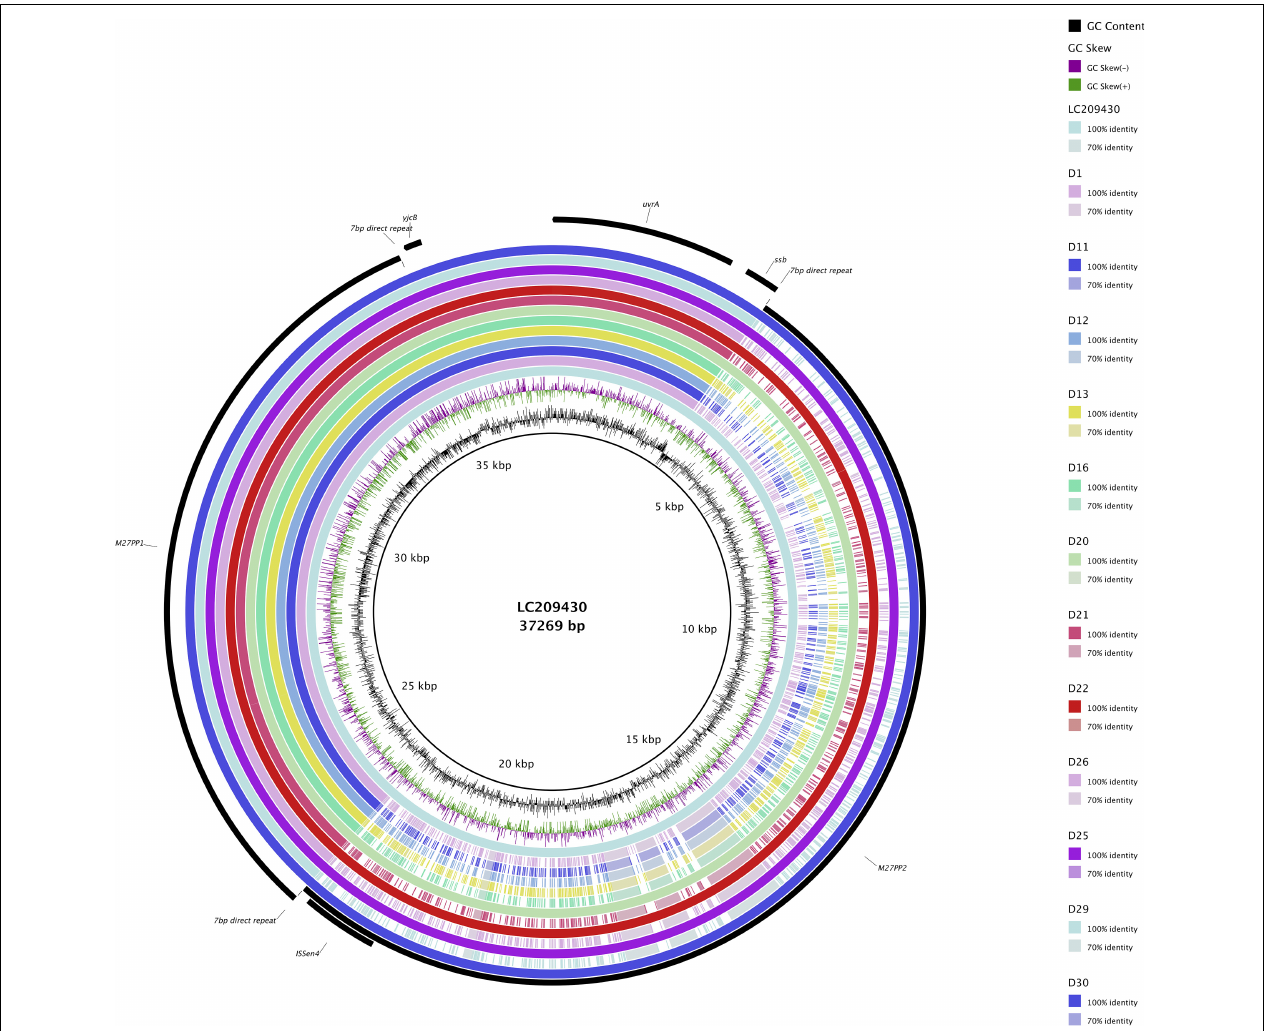
FIGURE 1 | ST131 Escherichia coli C1-M27 clade-specific regions, prophage-like genomic islands M27PP1 and M27PP2, of KUN5781 (GenBank accession: LC209430) compared to CTX-M-27-producing ST131 E. coli with fimH 30 allele from the current study. GC content and GC skew are depicted on the inner map with distance scale and predicted coding sequences depicted on the outer